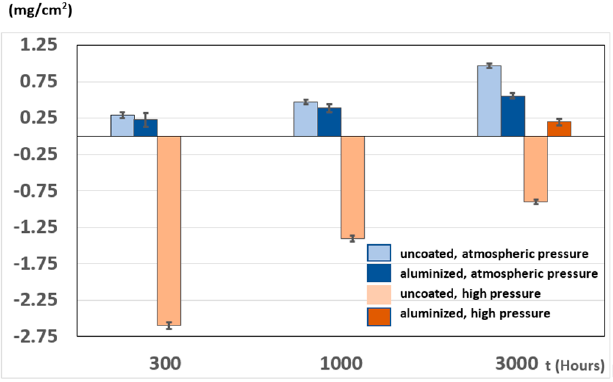
Figure 5. Mass variation of all tested specimens as a function of time exposed to steam at 700 °C.